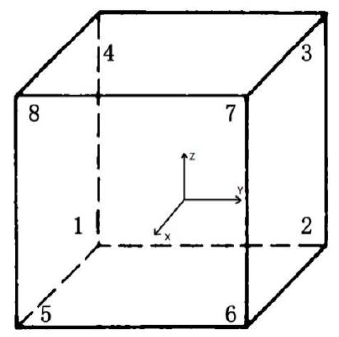
Figure 1. 3D hexahedron element and its coordinate system.